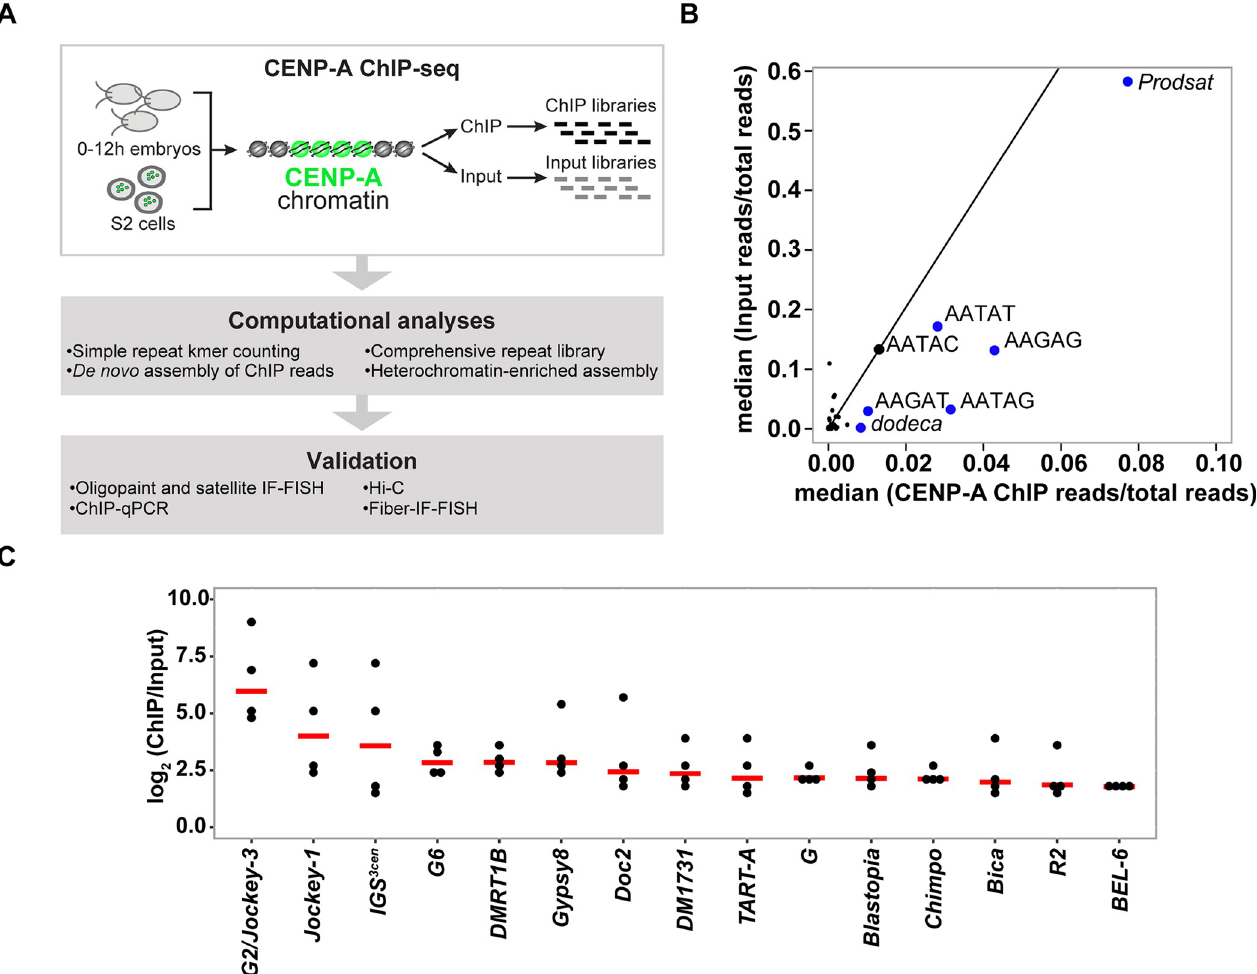
Fig 1. CENP-A binding association with satellites and transposable elements. (A) Schematic of the strategy used to identify the DNA sequence of D . melanogaster centromeres. The Illumina reads are 2 × 150 bp. (B) Kseek plot showing the relative abundance of simple repeat sequences in CENP-A ChIP compared to the input. Plotted on the x-axis is the median of CENP-A ChIP reads normalized over total mapped CENP-A ChIP reads across four ChIP replicates. Plotted on the y-axis is the median of input reads normalized over total mapped input reads across four replicates. The top 7 kmers in the ChIP read abundance are labeled. The line represents the enrichment of CENP-A ChIP/input for AATAC, a noncentromeric simple repeat. Repeats to the right of the line are putatively enriched in CENP-A. See also S1 Fig and S1 Table. (C) Plot of the normalized CENP-A/input reads on a log scale for each replicate, sorted by median (red lines) for complex repeat families. Shown are only the complex repeats in the top 20% across all four CENP-A ChIP replicates. See also S2 Fig and S2 Table. CENP-A, centromere protein A; ChIP, chromatin immunoprecipitation; ChIP-seq, ChIP sequencing; IF-FISH, immunofluorescence–fluorescence in situ hybridization; IGS 3cen , intergenic spacer of the ribosomal genes on the third centromere; Prodsat , Prod satellite; qPCR, quantitative PCR; S2, Schneider 2; TART , Telomere-associated